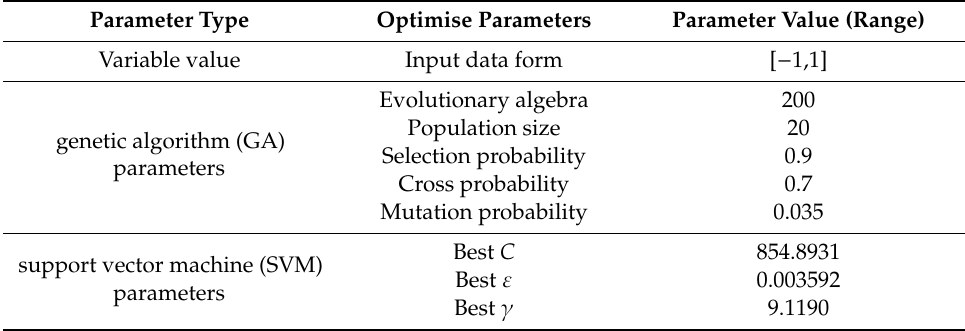
Table 2. Optimal parameters of the GA-SVM model for gas hydrate